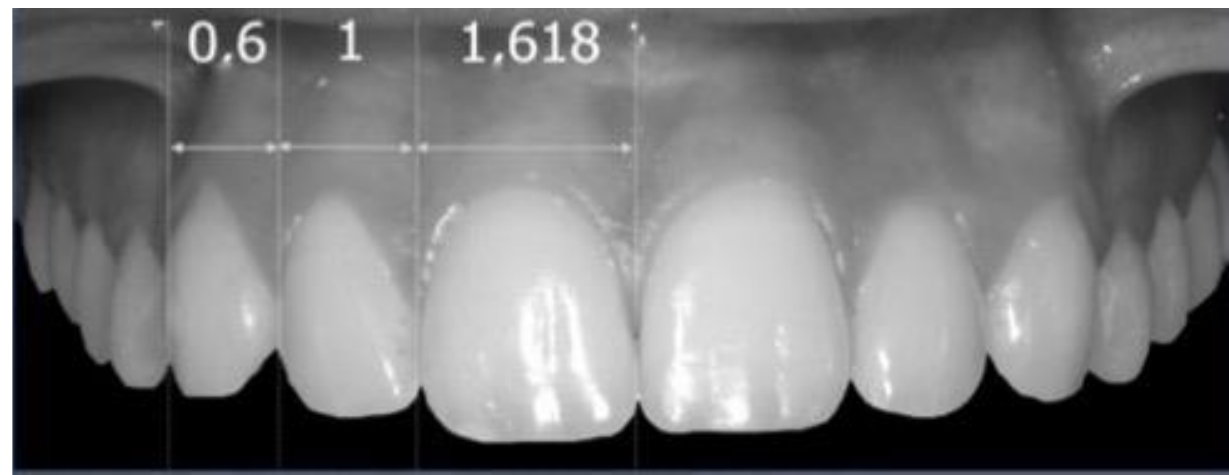
Figure 2. Representative image of GP theory. -